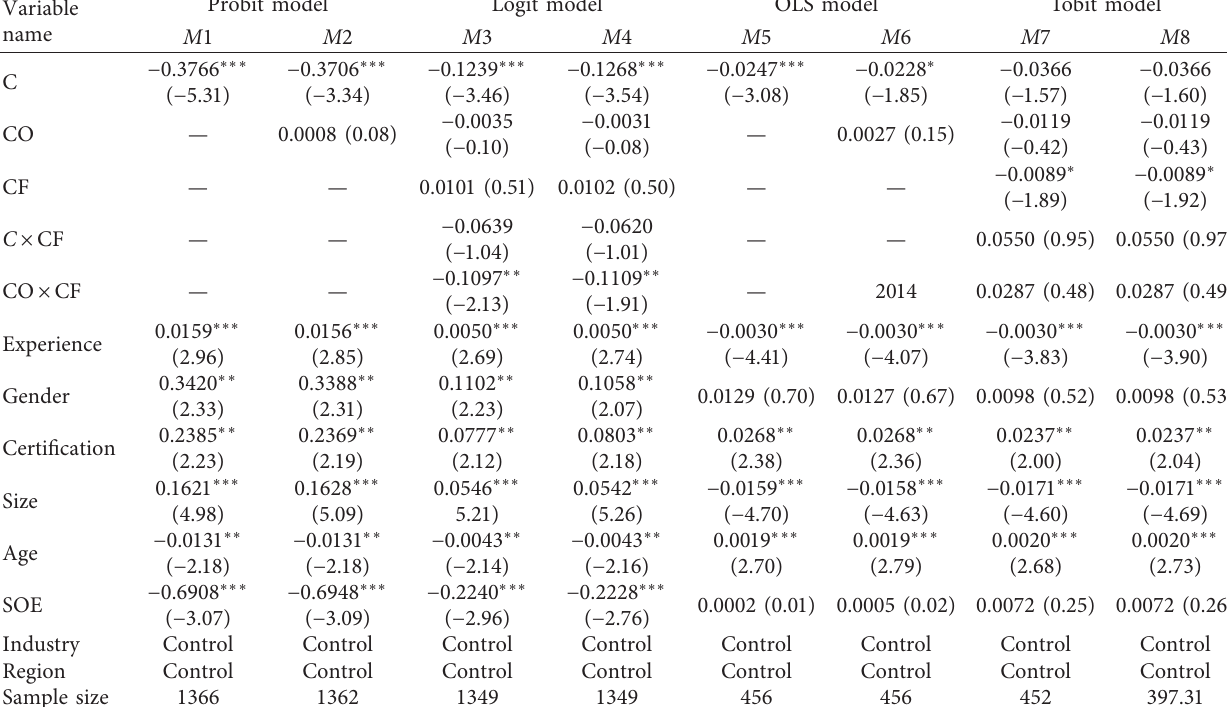
Table 4: Preliminary regression results of the